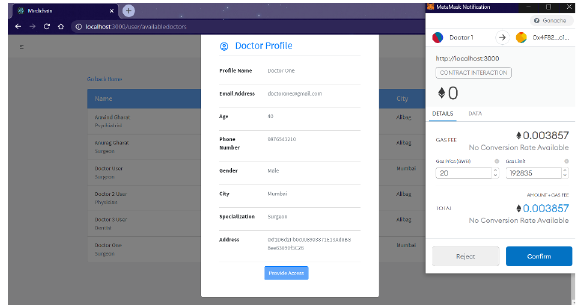
Figure 6. Providing Access to